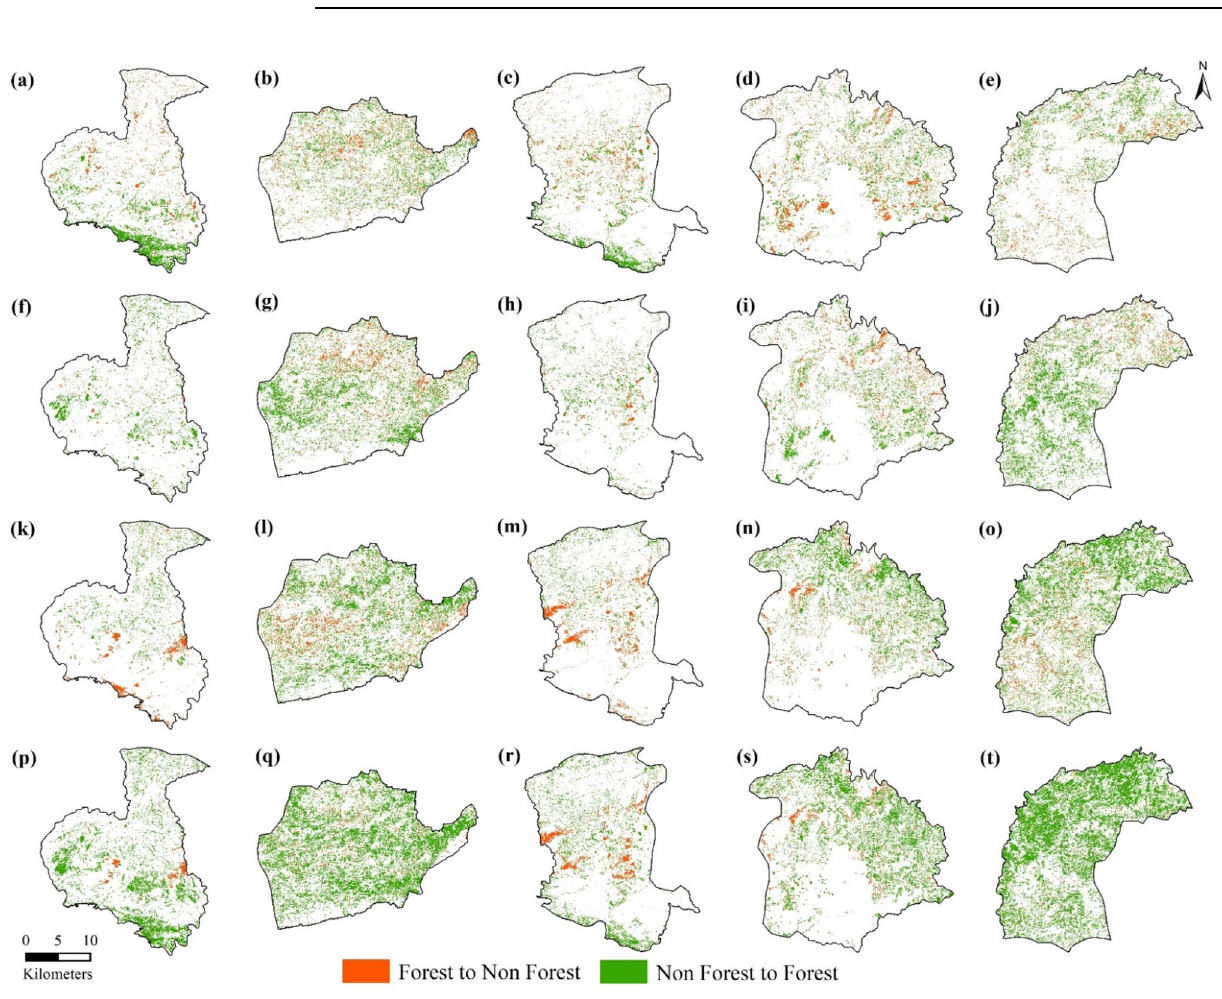
Fig. 8 Change category maps of ( a ) Amlarem ( b ) Laskeiñ ( c ) Khliehriat ( d ) Saipung ( e ) Thadlaskeiñ for 1995–2001: ( f ) Amlarem ( g ) Laskeiñ ( h ) Khliehriat ( i ) Saipung ( j ) Thadlaskeiñ for 2001